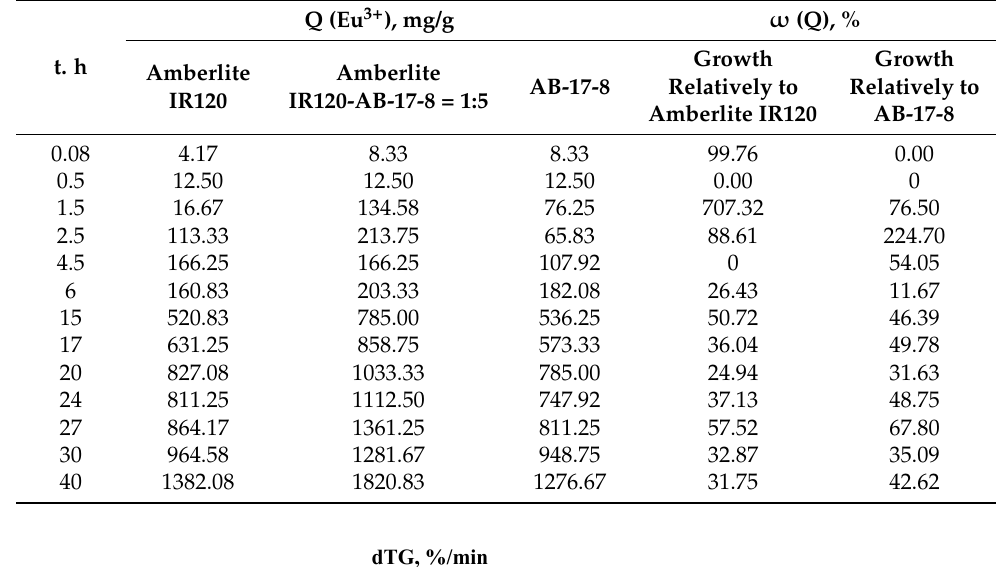
the fact that there is less sorbed metal in the structure. The temperature range from 400 ° C to 625 ° C can be named as the stabilization area with indications of the process ending.